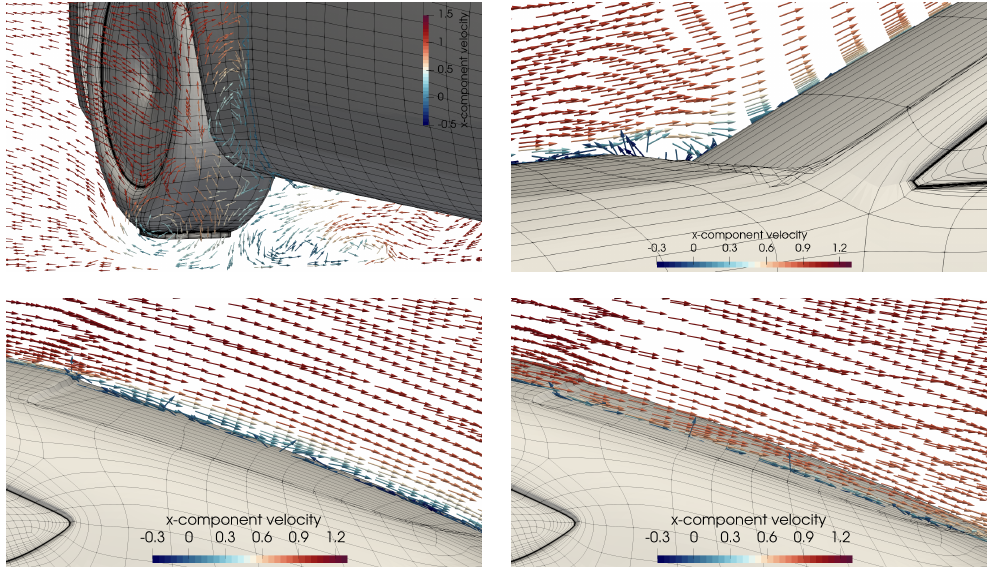
Figure 19. DrivAer model—Details of the time-averaged velocity vectors behind the front wheels ( top , left ), in the gap between the cowl top and the windshield ( top , right ) and on the rear slant ( bottom